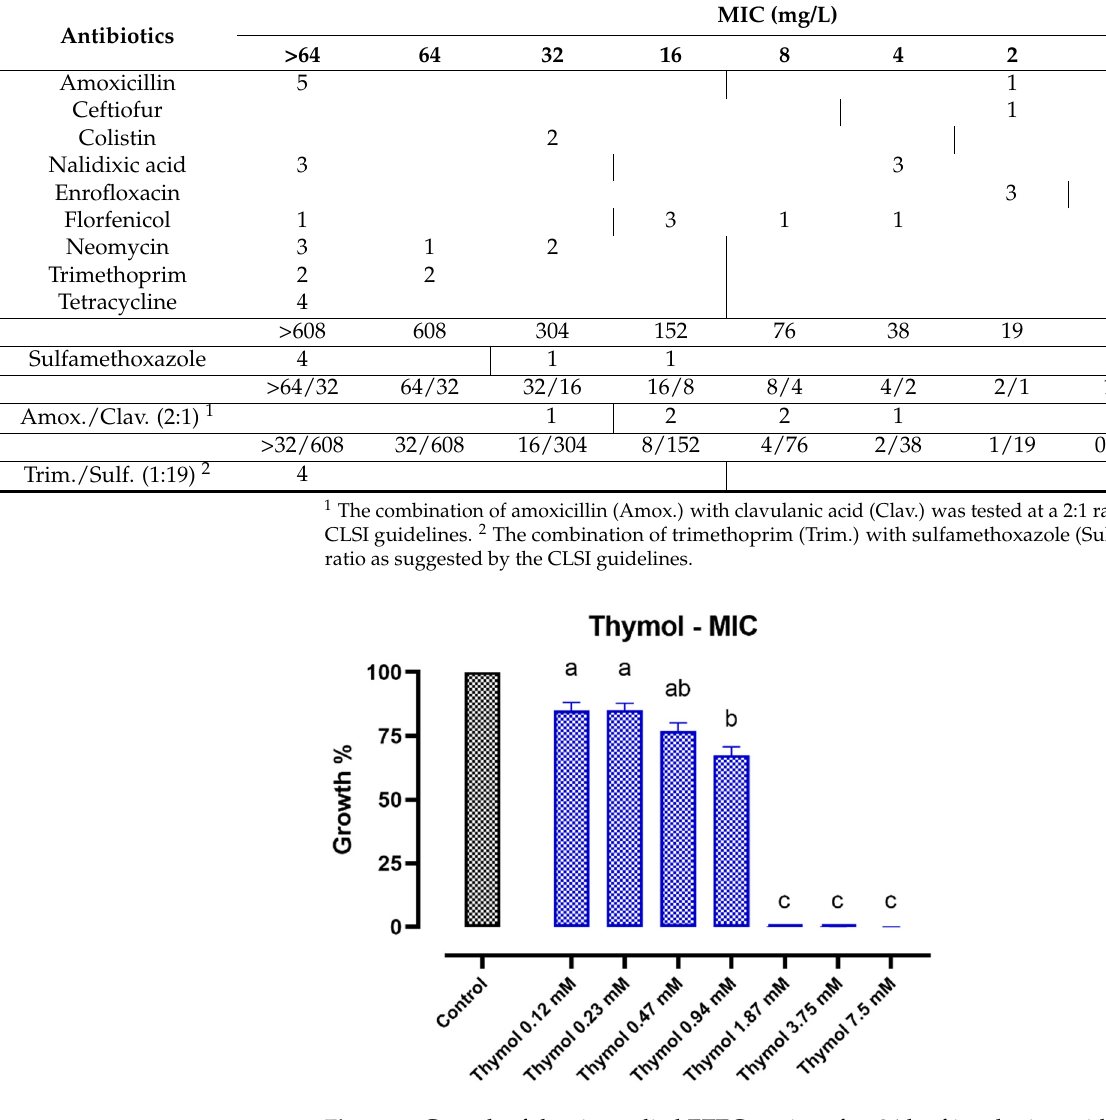
Figure 1. Growth of the six studied ETEC strains after 24 h of incubation with thymol. Growth is expressed as a percentage relative to the control (strain only); values are presented as means ± SEM of the mean growth of each strain for each concentration of thymol. Data were analyzed by one-way ANOVA with Tukey’s multiple comparison test; superscript letters (a, b, c) indicate significant differences among different doses ( p < 0.05).